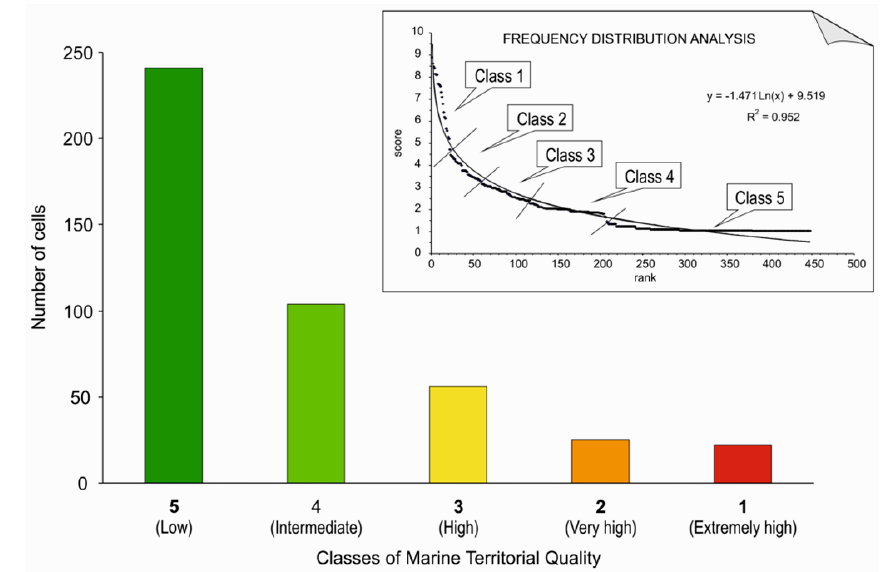
Figure 1. Procedure to assign territorial units (grid cells) with evaluation classes through frequency distribution analysis of the scores of the cells contained in every individual